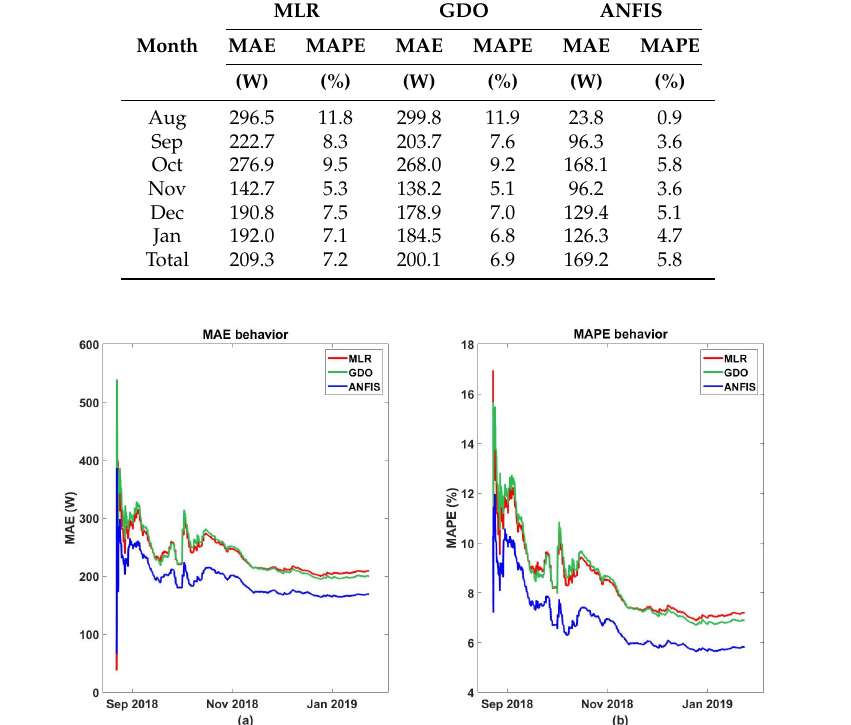
Figure 13. Error behavior comparison between MLR, GDO and ANFIS from HS: ( a ) MAE behavior; ( b ) MAPE